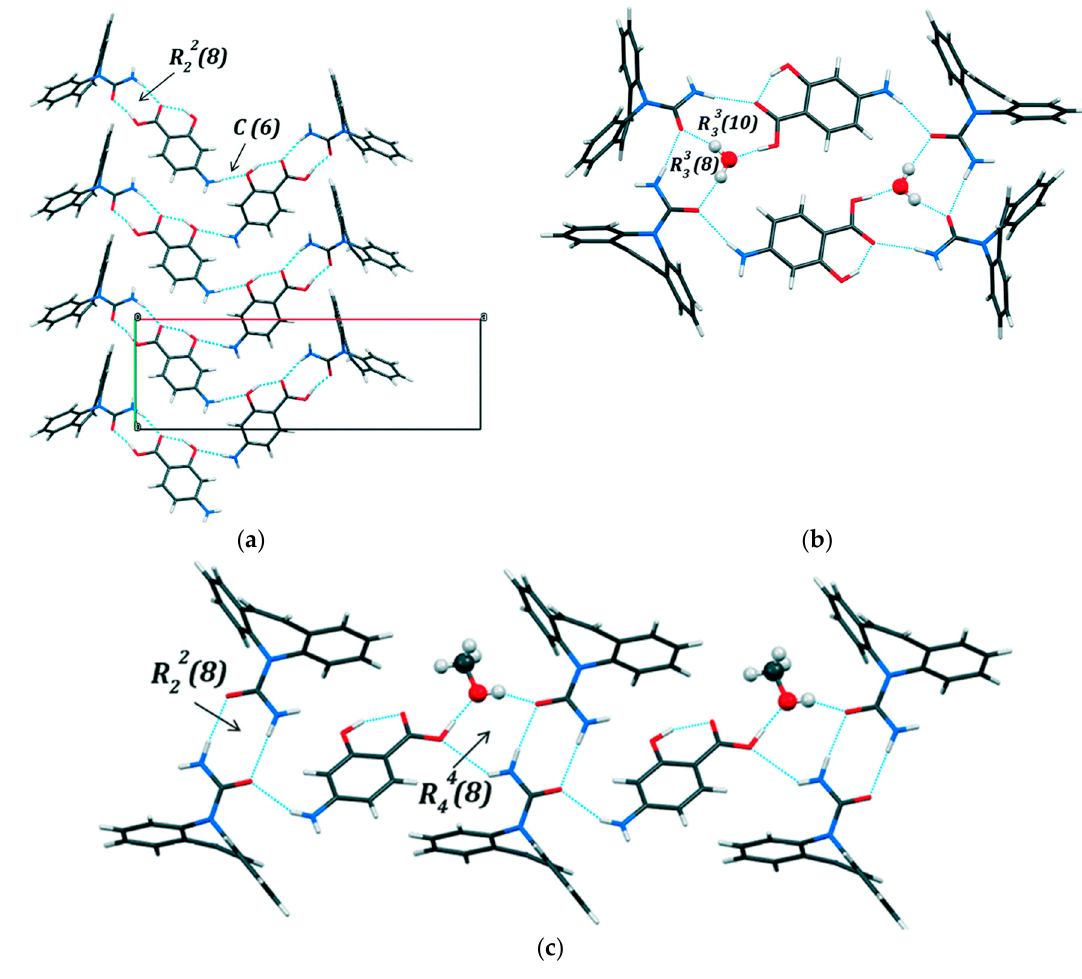
Figure 18. Hydrogen bond interaction present in ( a ) 1:1 CBZ-PAS cocrystal; ( b ) 2:1:1 CBZ-PAS-water and ( c ) 2:1:1 CBZ-PAS-methanol structure. Adapted with permission from CrystEngComm , 2017, 19, 4273–4286. Copyright 2017, The Royal Society of Chemistry.